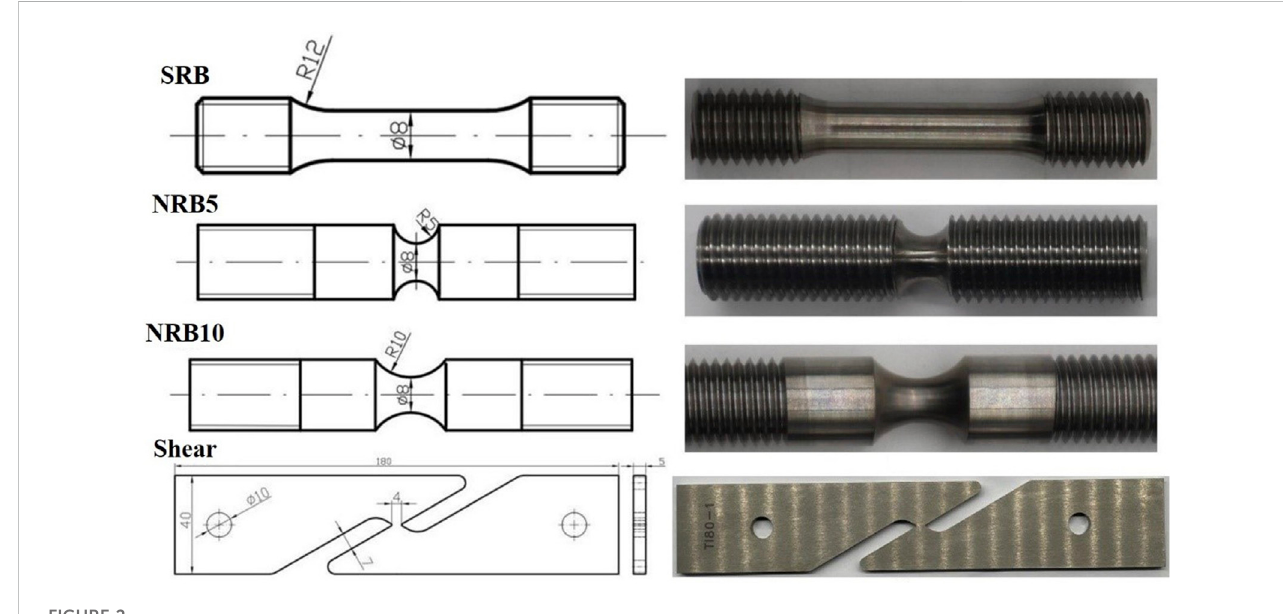
FIGURE 2 Specimen geometries.